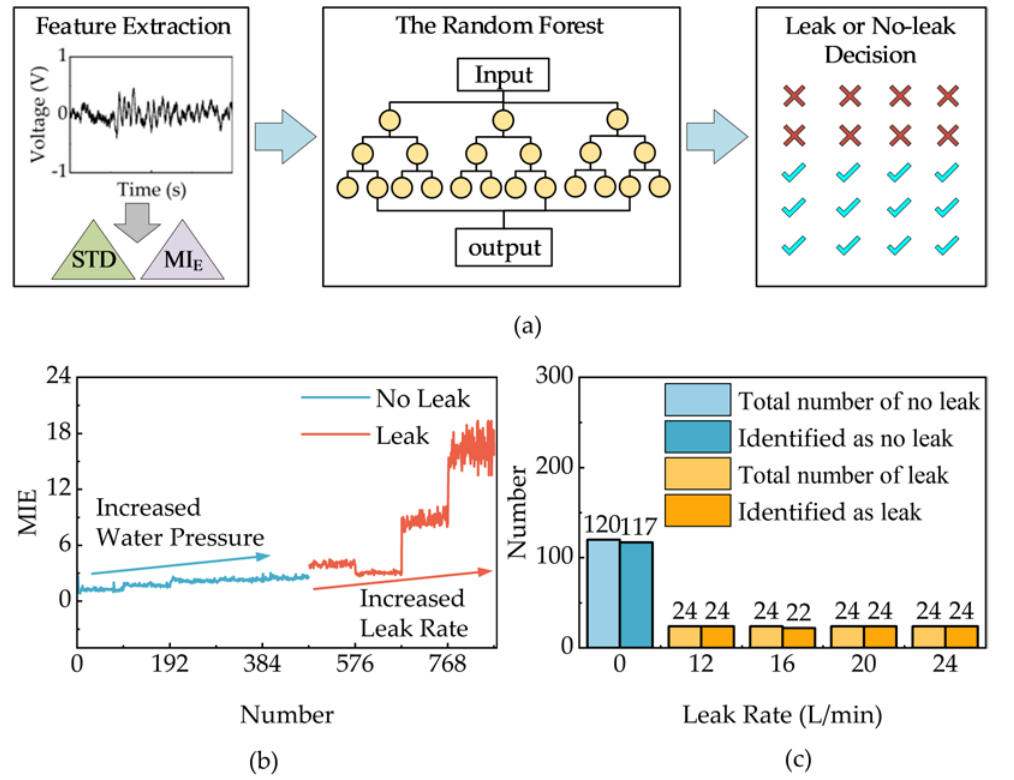
Figure 9. Leak detection chart: ( a ) the specific implementation process, ( b ) MIE value of the training dataset after filtering, ( c ) the results of the validation dataset after filtering .